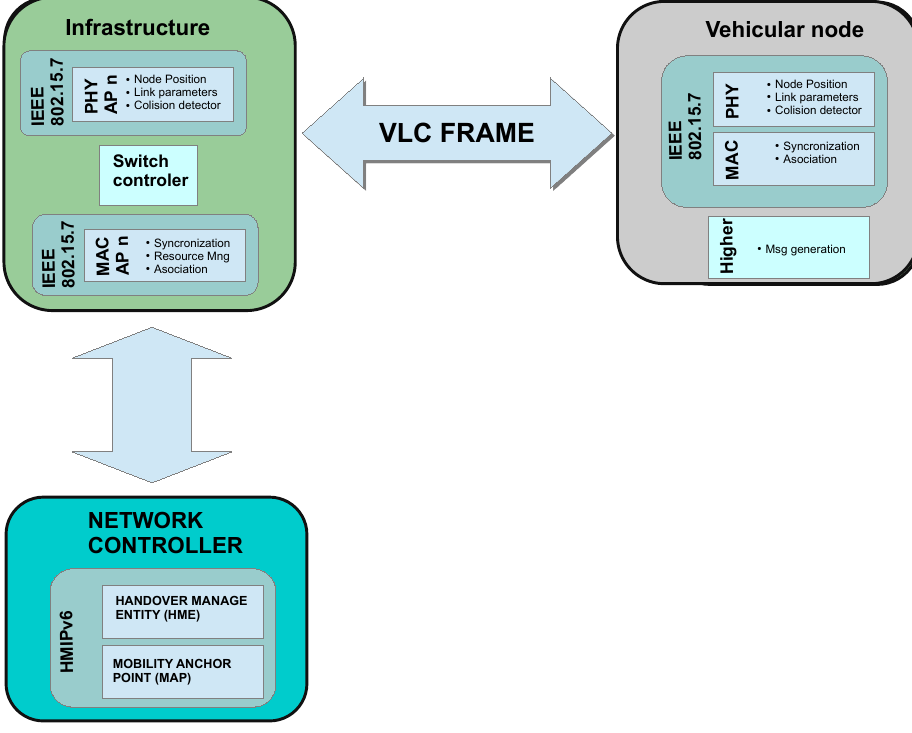
Figure 10. OMNet++ framework for handover simulation in VLC networks.